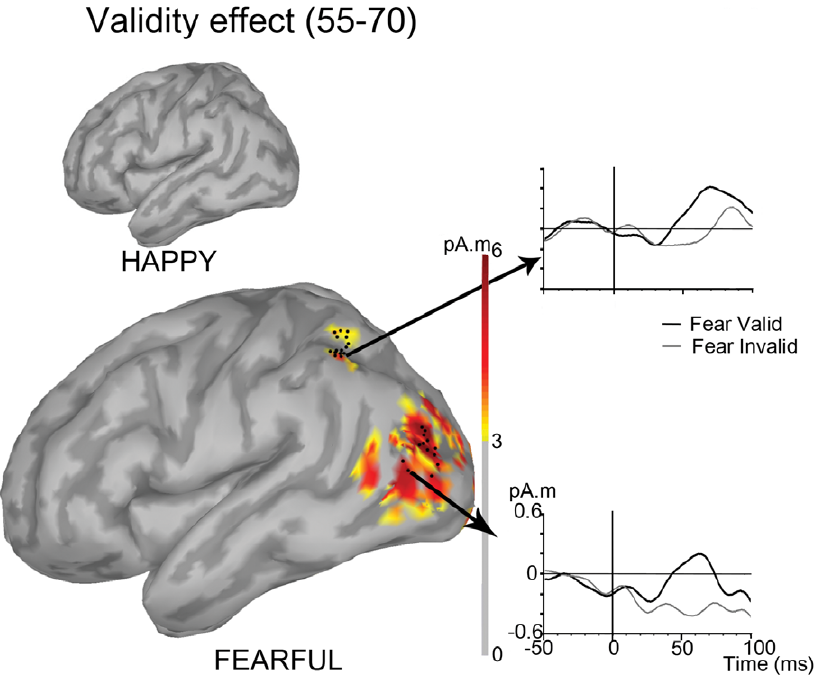
Figure 4. Source localization of the early attention orienting effect induced by fearful gaze cues. The grand average of the mean source amplitude difference between the valid and the invalid conditions in the 55–70 ms time window are projected on a left lateral view of a template brain. Only sources with a mean amplitude of source activation difference above 3 pA.m are represented. The black dots represent the cortical sources where the cue-target validity effect reached significance (p , .001; 15 vertices in the left superior parietal lobule region and 13 vertices in the left lateral middle occipital gyrus region). The smaller brain on the top illustrates the absence of significant activation in response to valid versus invalid targets in the same time window for happy gaze cues. On the right: Grand mean time course of the vertex showing the maximal source amplitude difference for valid versus invalid targets following fearful gaze cues.